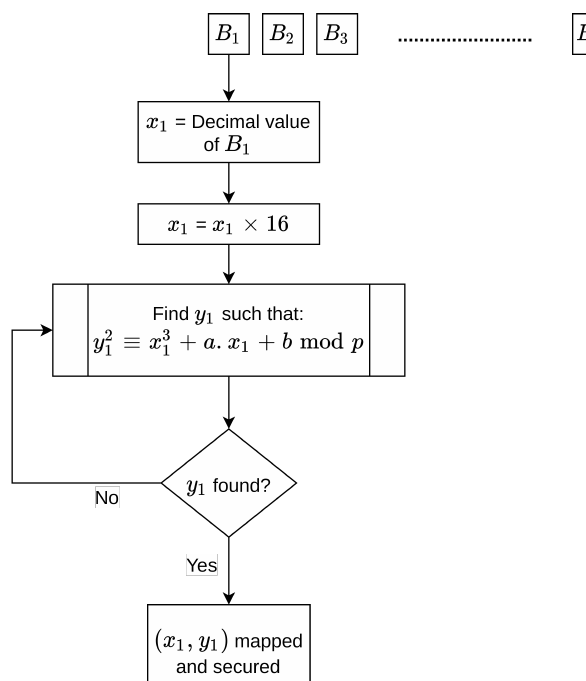
Figure 9. Mapping secured blocks to an elliptic curve.